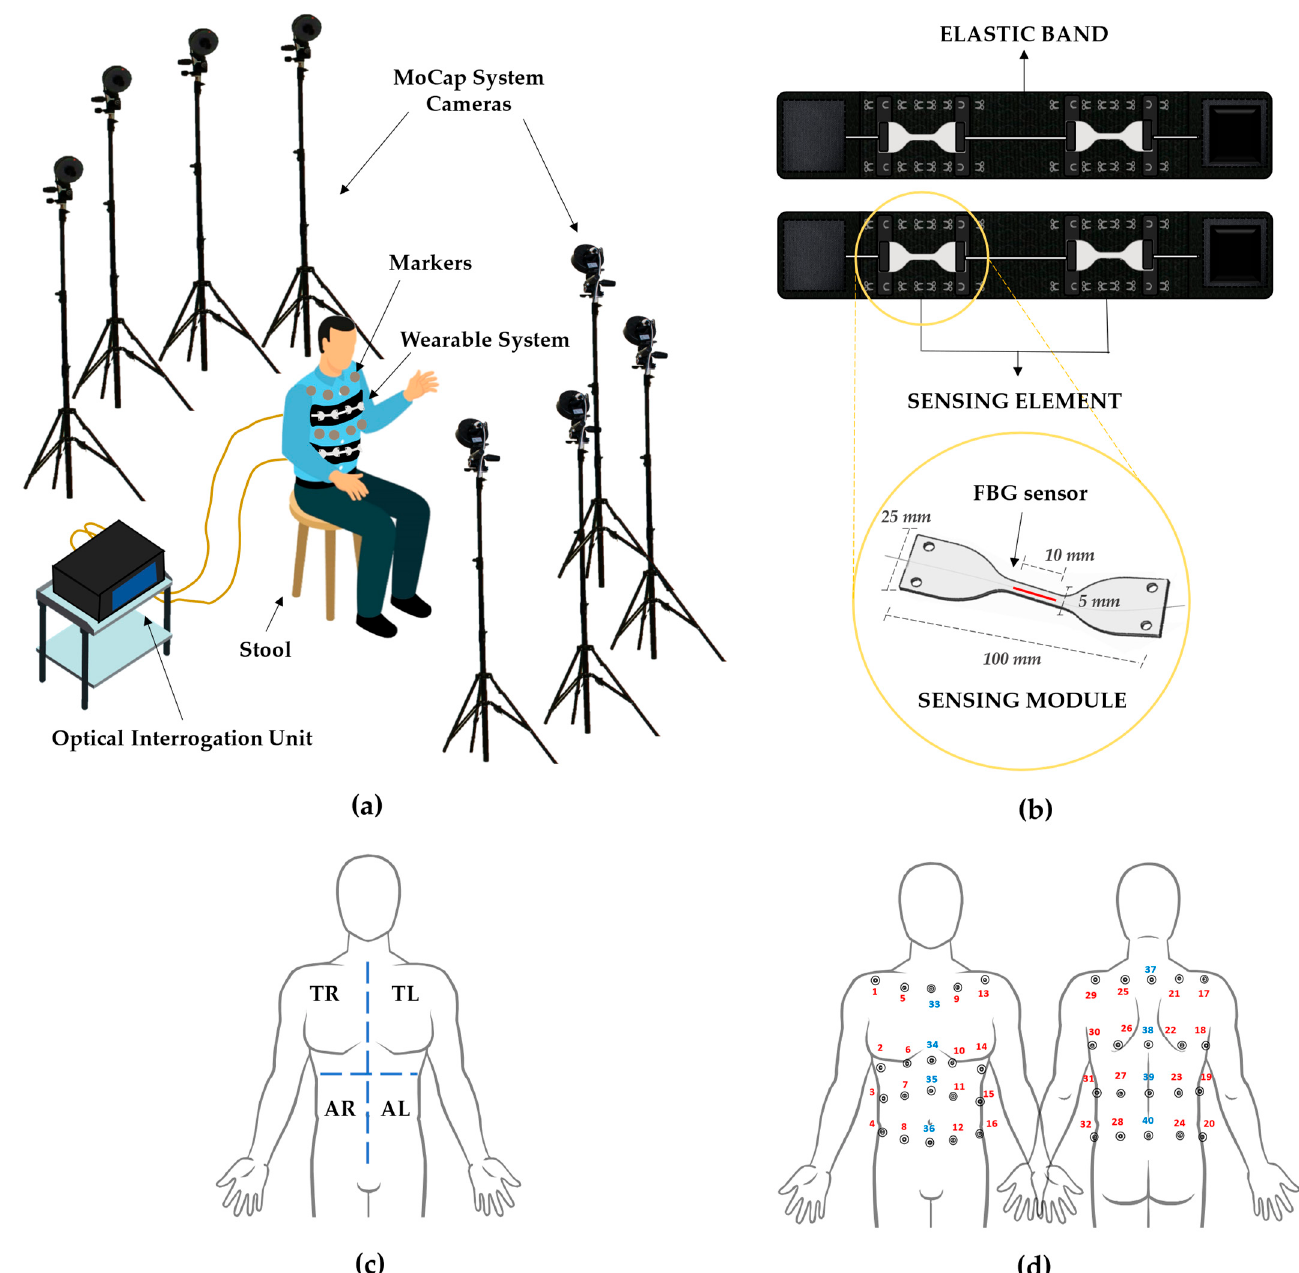
Figure 1. The experimental set-up, composed of a stool, the eight cameras of the motion capture system, the reflective markers, the wearable system, and the optical interrogation unit, is depicted in ( a ). In ( b ), an insight into the wearable system is given, showing the two elastic bands, each of which is equipped with a sensing element. In addition, a magnification of a sensing module is reported. In ( c ), the four macro-areas (right thorax—TR, left thorax—TL, right abdomen—AR, and left abdomen—AL) into which the torso is subdivided are displayed. In ( d ), the positioning of the 40 reflective markers on the subject’s torso is shown.